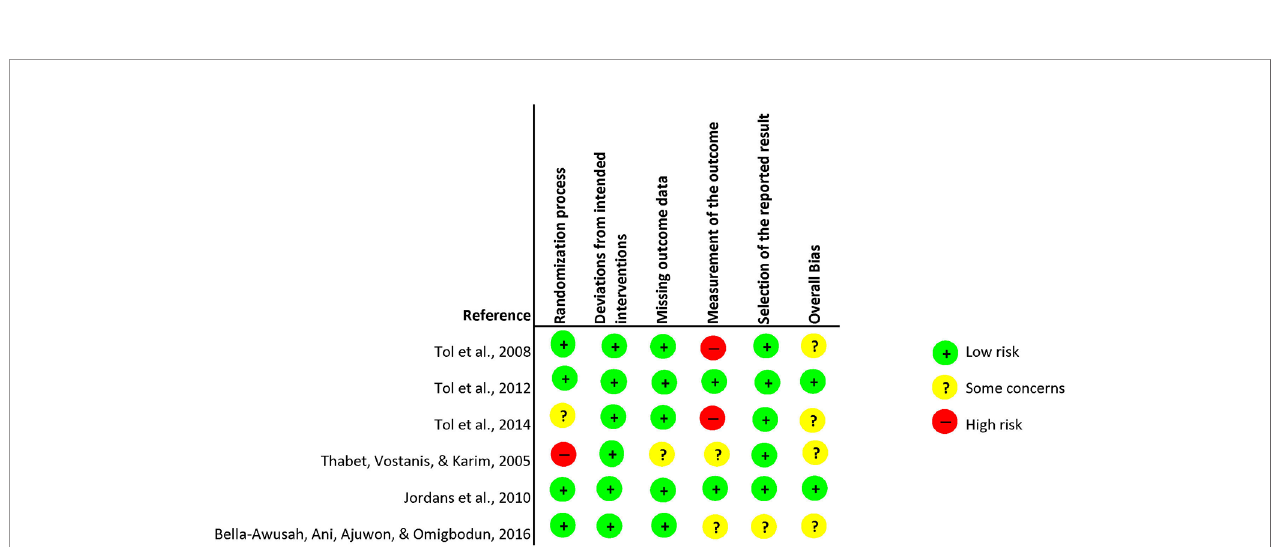
FIGURE 3 | Risk of Bias Cluster Randomized Controlled